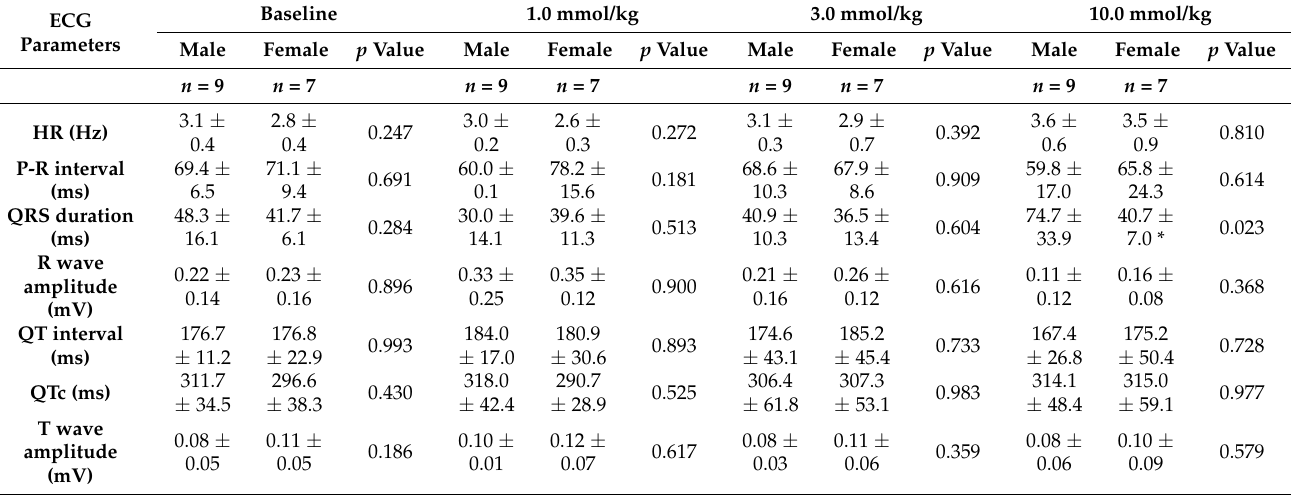
Table 1. ECG parameters before and after intravenous lithium administration at different concentra- tions.